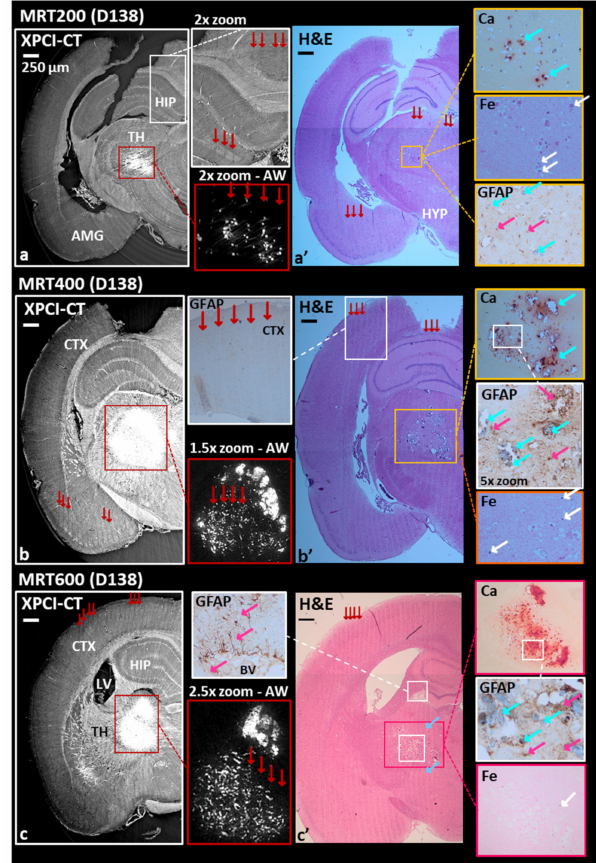
Figure 3. MRT-treated healthy samples: coronal XPCI-CT images compared with histology and immunohistochemistry on the irradiated brain hemisphere. MRT200 sample reports some hyperdense agglomerates in the thalamus (TH) ( a ) that are better visible in the adjusted windowing inset and are recognized as Ca and Fe deposits thanks to the H&E, Alizarin Red and Perl’s Prussian Blue histologies ( a’ ). Iron deposits are pointed out by white arrows, while red arrows identify the MRT paths. The GFAP staining of the thalamus area ( a’ inset), shows limited gliosis in two zones. Magenta arrows are for astrocytes and cyan arrows for Ca deposits. MRT paths are visible in both XPCI-CT and histology as tissue ablation in the hippocampus (HIP), thalamus, hypothalamus (HYP) and amygdala (AMG) as visible in the 2 × zoom of ( a ) and in ( a’ ). MRT400 ( b ) and MRT600 ( c ) samples manifest big cluster of Ca/Fe deposits together with small dot-shaped ones. The different applied stainings reveal a low content in Fe and massive astrogliosis in the deposit surroundings (GFAP staining of ( b’ ) and ( c’ )). MRT paths are visible in both XPCI and histologic images. In particular, the cortex (CTX) GFAP inset of ( b’ ) demonstrate that no gliosis is induced by MRT irradiation without being entangled to Ca